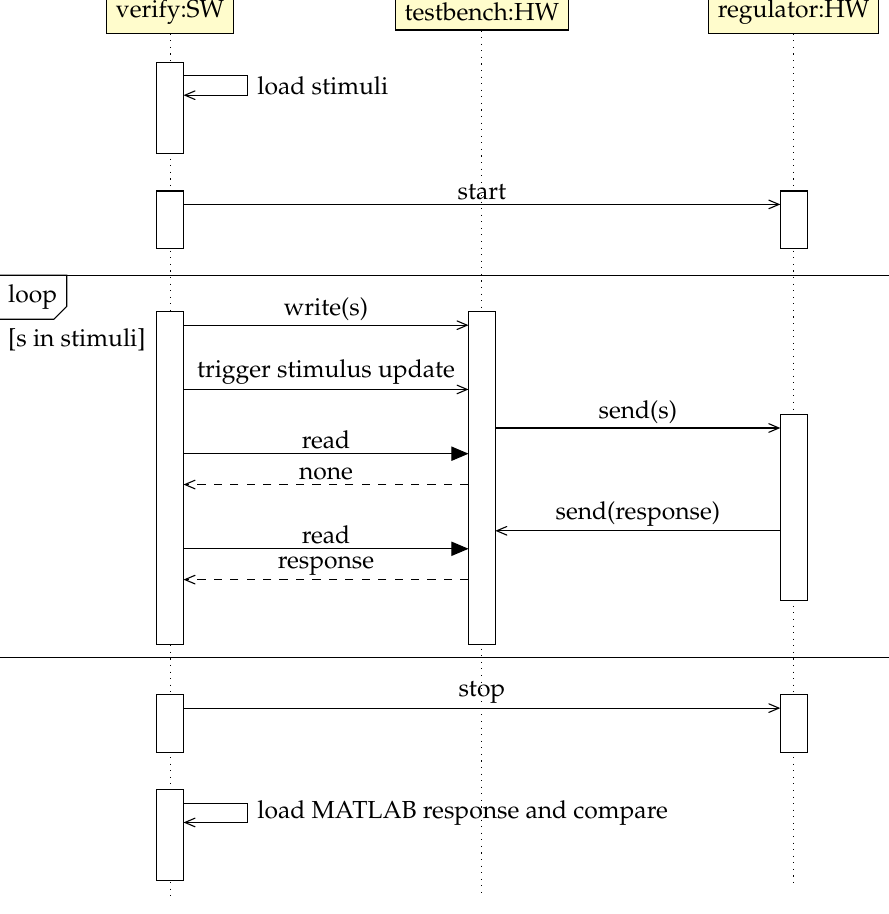
Figure 20. Comparison of MATLAB and testbench time responses for a 4th-order regulator